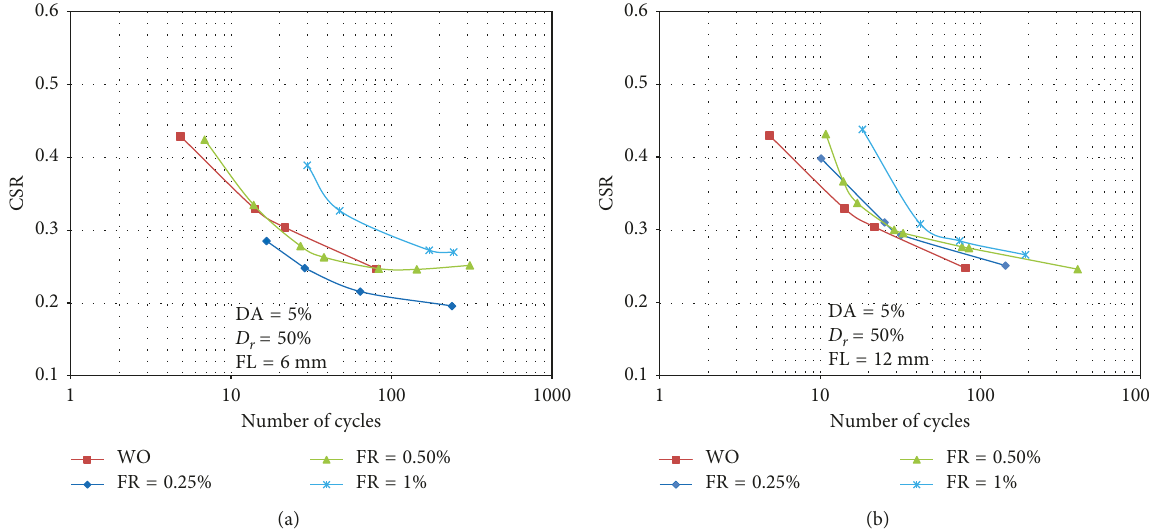
30%, and σ 0 100kPa). (cid:31) (cid:31) ′